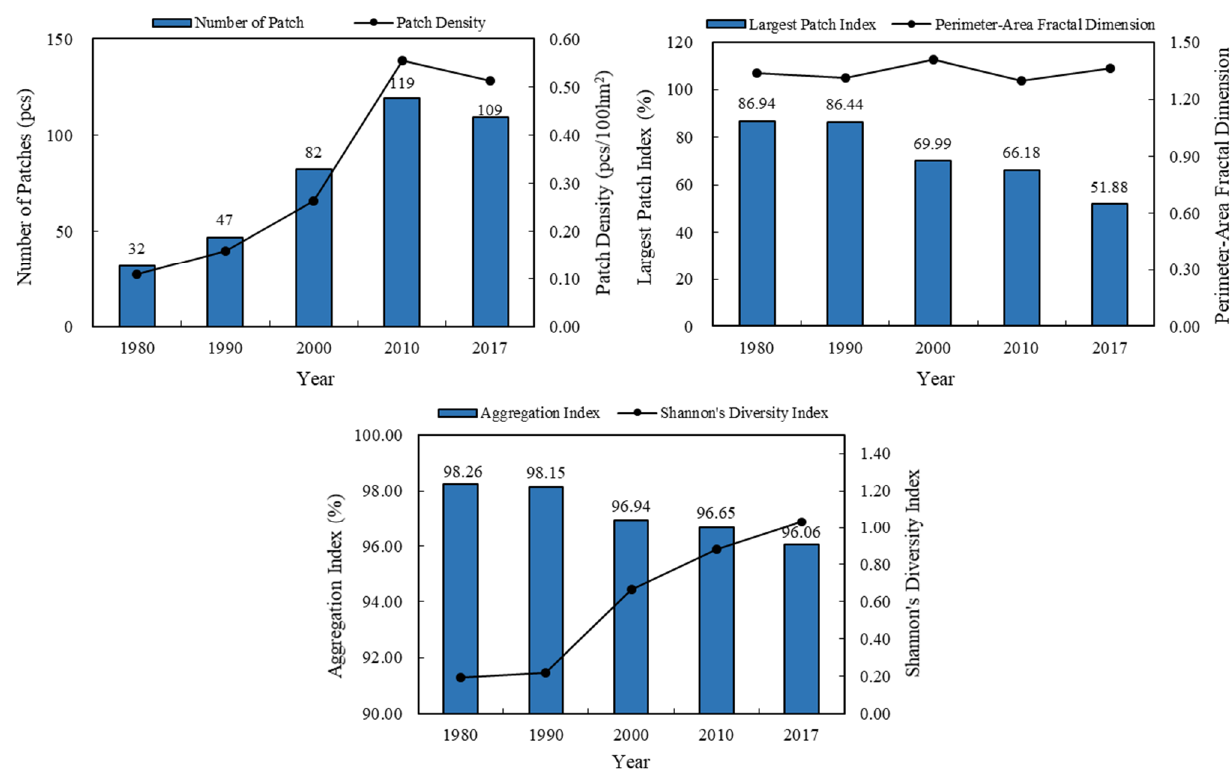
Figure 7. Changes in the landscape indexes (NP, PD, LPI, PAFRAC, AI, and SHDI) at the landscape scale in the Xiong’an New Area from 1980 to 2017.